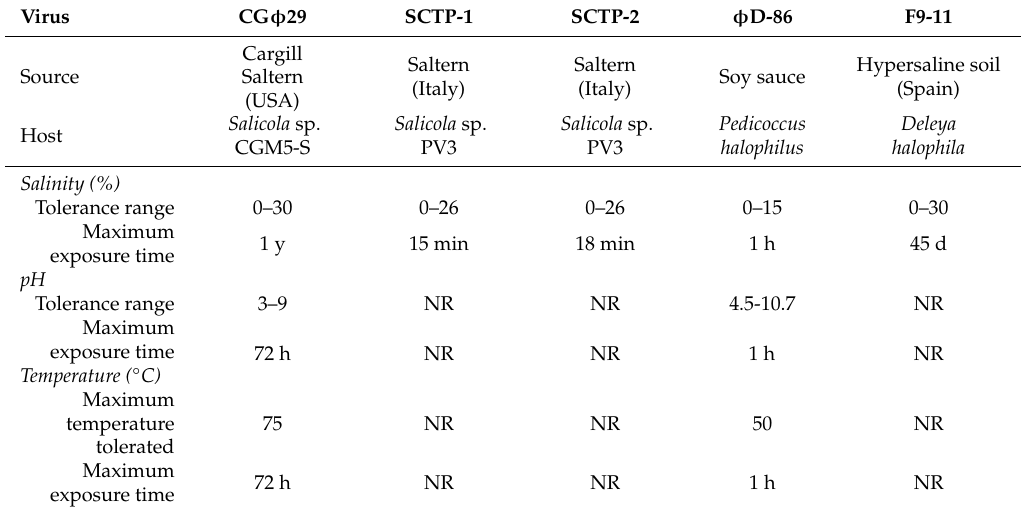
Table 2. Physicochemical responses of CG φ 29 and other described bacterial halophilic viruses 1